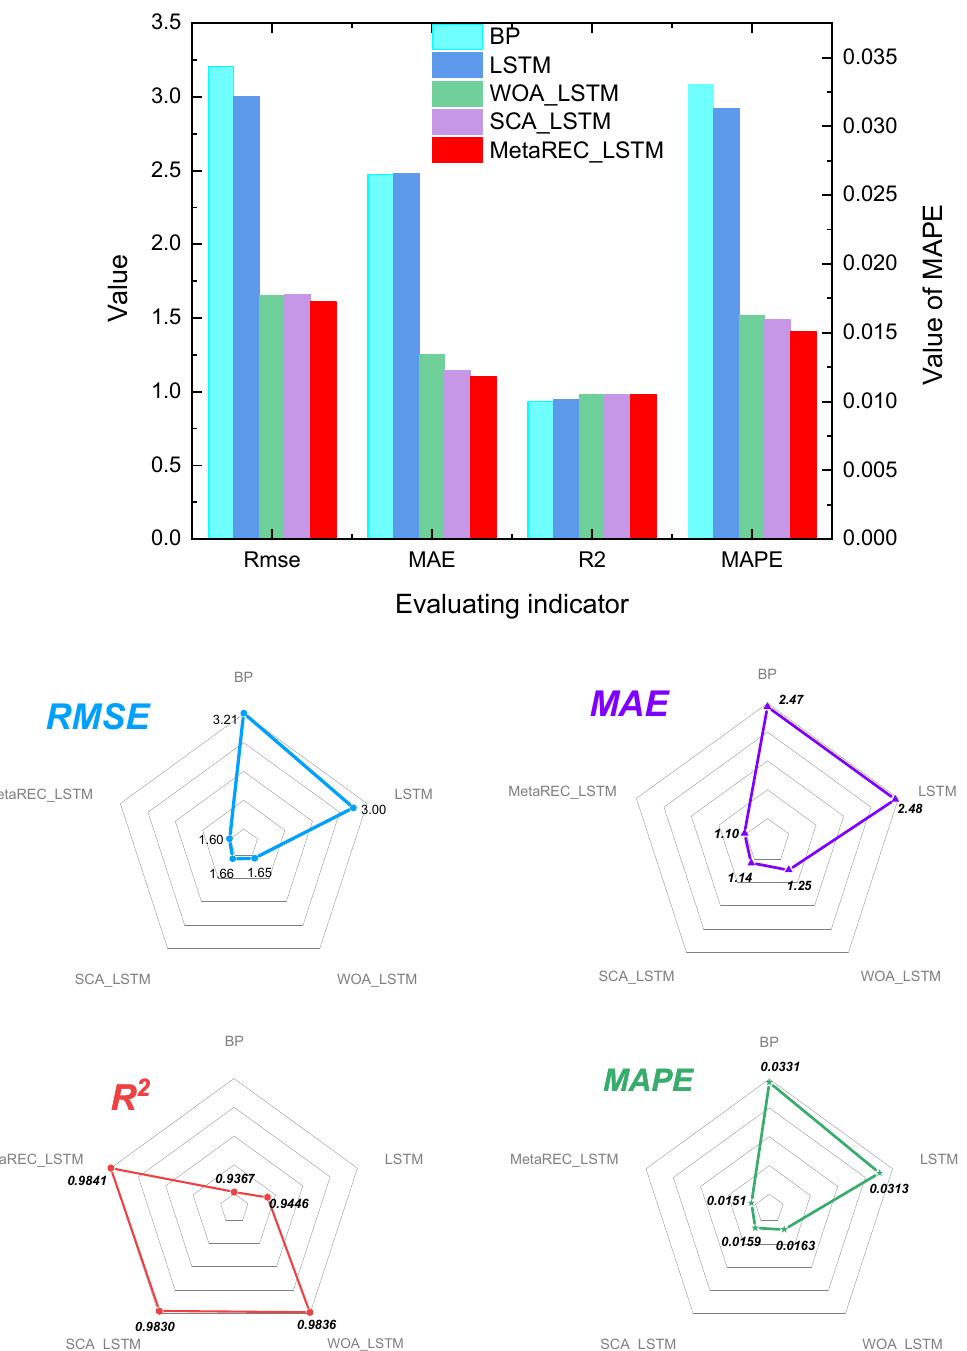
Figure 15. Comparison of assessment indicators for multiple forecasting methods. Table 7. Results of forecasting criteria evaluated by different methods.